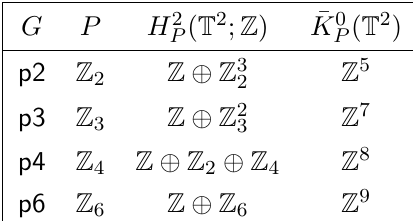
Table 2 . m = 1 , d = 2 fermionic symmorphic crystallographic phases ( H 2 Z F parity index vs d = 2 symmorphic crystallographic non-interacting fermionic phases ( ¯ K 0 2 Symmetry groups are those without reflections i.e. p2 , p3 , p4 and p6 . We have removed the non- physical virtual dimension Z -factor included in [24]. For these groups there are many more non- interacting phases than interacting ones. Input taken from [28] and